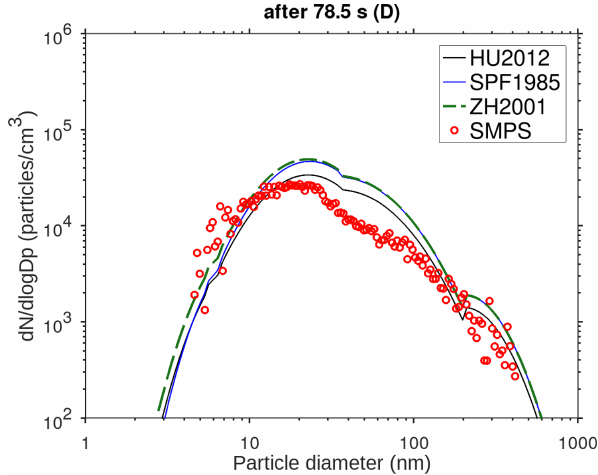
Figure E2. Modelled particle number size distribution with MAFOR using different dry deposition parameterizations at point D (after 78.5s of plume transport time). HU2012 is the reference dry deposition configuration used in MAFOR, SPF1985 is the dry deposition scheme in AEROFOR, and ZH2001 is the dry deposi- tion scheme in SALSA. Measured size distributions from SMPS are shown as red